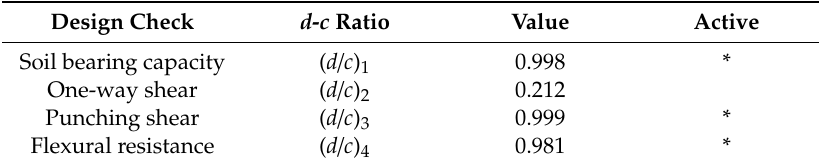
Table 9. Example 2: Demand–capacity ratios corresponding to the optimum design